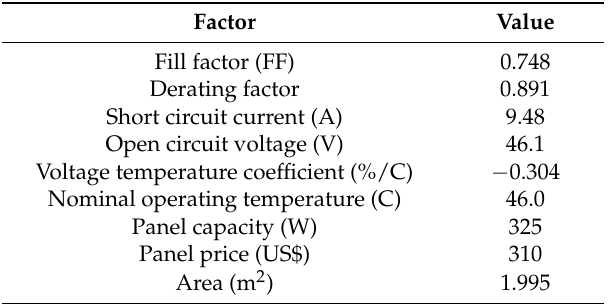
Table 1. Specifications SW325XL panel at standard test